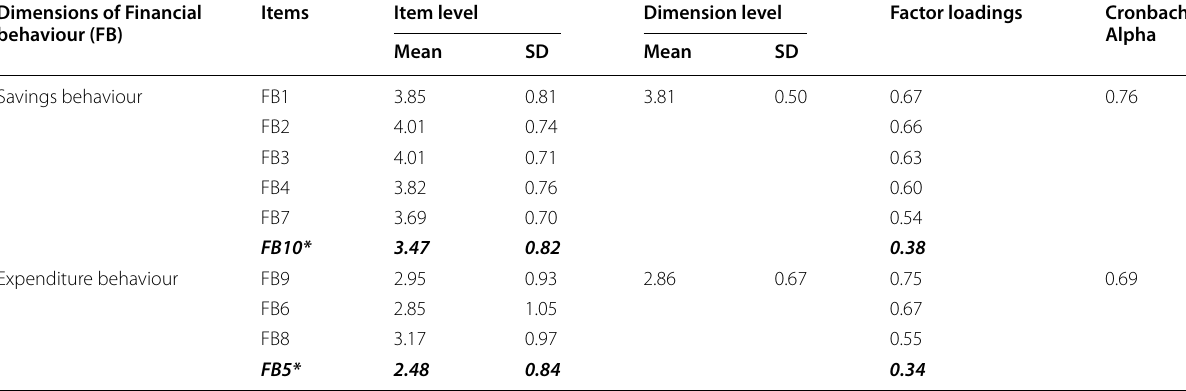
Table 12 EFA results for the financial behaviour (FB)